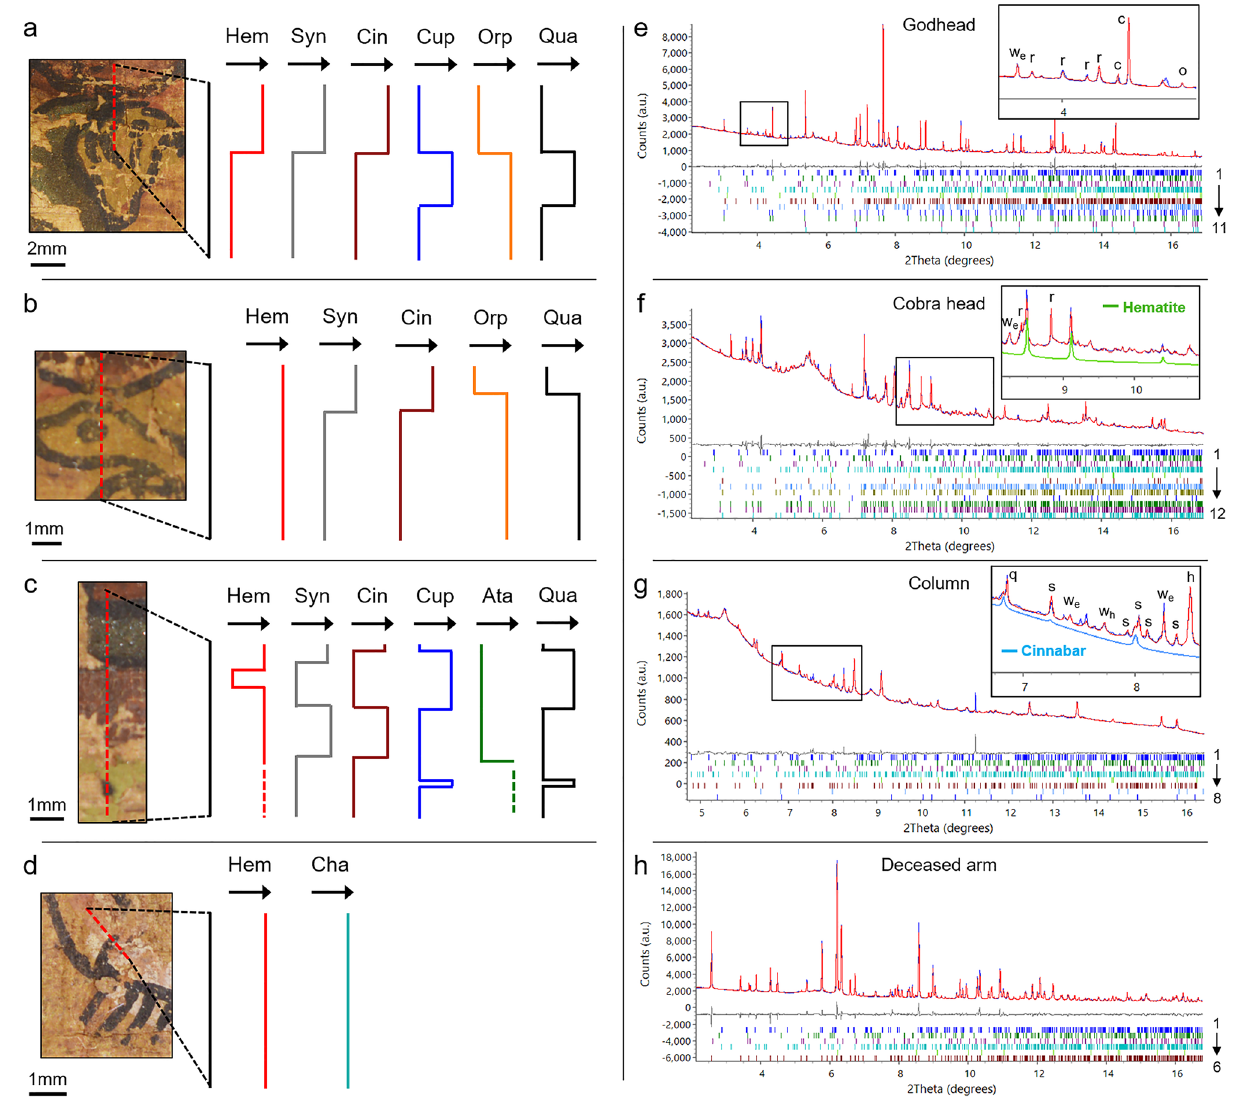
Figure 3. Phase profiles obtained from X-ray diffraction data recorded along the four red lines on ( a ) the Godhead, ( b ) the Cobra head, ( c ) the column, and ( d ) the arm of the deceased. Only the main relevant phases are indicated. The black arrows indicate the absence or presence of each phase, with no information on their relative amount. Hem hematite, Syn syngenite, Cin cinnabar, Cup cuprorivaite, Orp orpiment, Qua quartz, Ata atacamite, Cha challacolloite. Rietveld and Pawley refinements against diffraction data collected on ( e ) the Godhead, ( f ) the cobra head, ( g ) the column, and ( h ) the arm of the deceased (thin blue line: measured pattern, red line: calculated pattern, grey line: difference, phases 1–4 correspond to the two cellulose phases, weddellite (w e ) and whewellite (w h )). ( e ) Cuprorivaite (c), orpiment (o) and realgar (r) co-exist in the same region of the Godhead (phases 5–11: aphthitalite, realgar, orpiment, cuprorivaite_SC1 and _SC2, quartz_SC1 and _SC2, with SC1 and SC2 representing two large-grain contributions of the same phase, see Fig. S3; R wp 2.82%). ( f ) Hematite from the preparatory drawing is present in the cobra head (phases 5–12: hematite, aphthitalite, realgar, orpiment, quartz_SC, realgar_SC1 and _SC2 (r), orpiment_SC; R wp 1.50%). ( g ) A small amount of cinnabar is present in the red part of the column (phases 5–8: hematite (h), syngenite (s), cinnabar, quartz_SC (q); R wp 0.78%). ( h ) Rietveld refinement against diffraction data collected on the arm of the deceased (phases 5–6: hematite, challacolloite; R wp